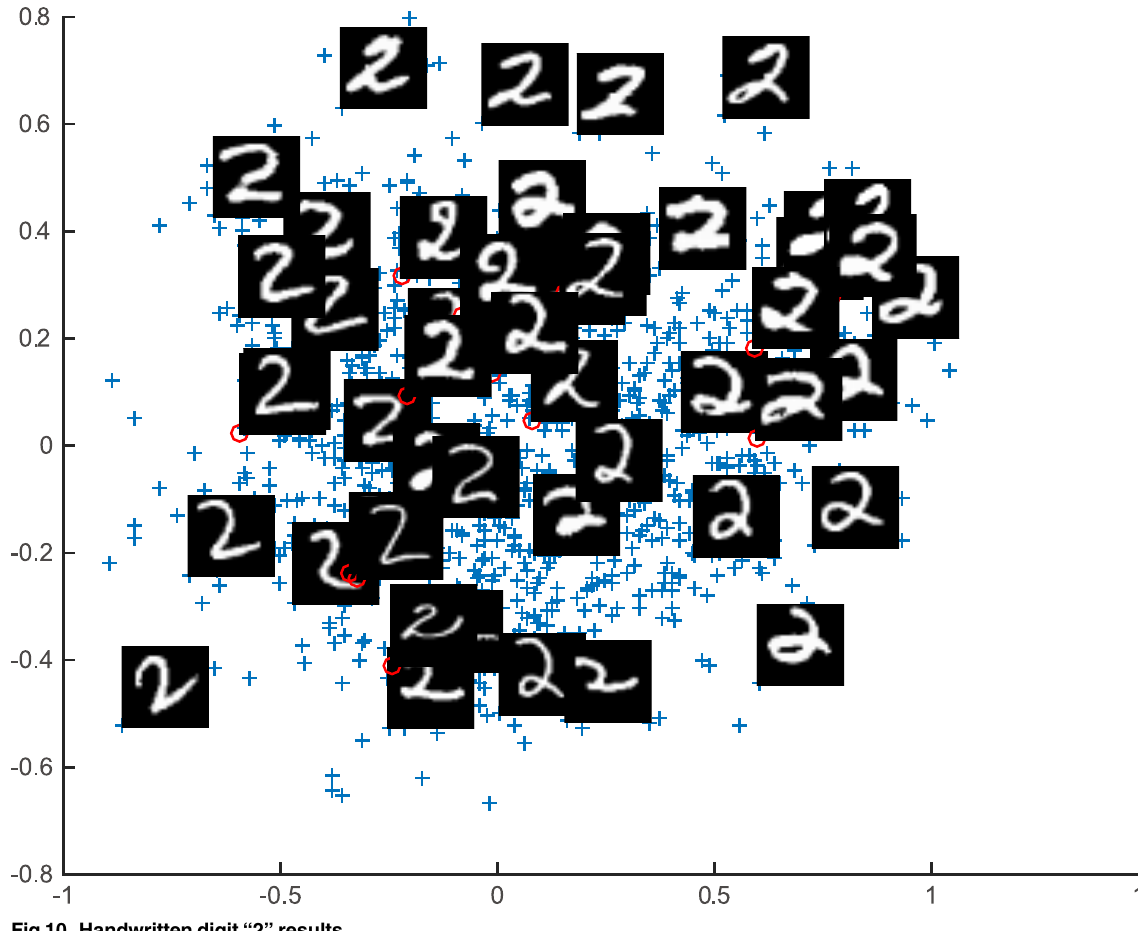
Fig 10. Handwritten digit “ 2 ”